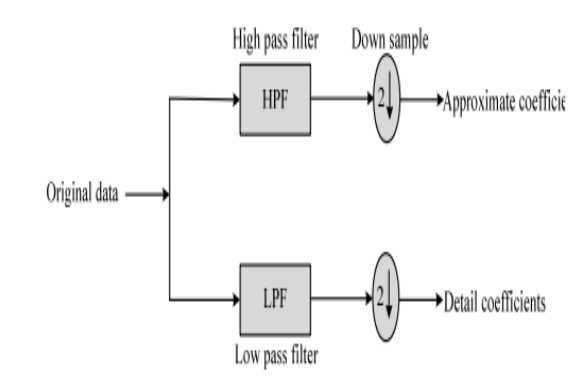
Figure 2. Block diagram of 1D forward DWT